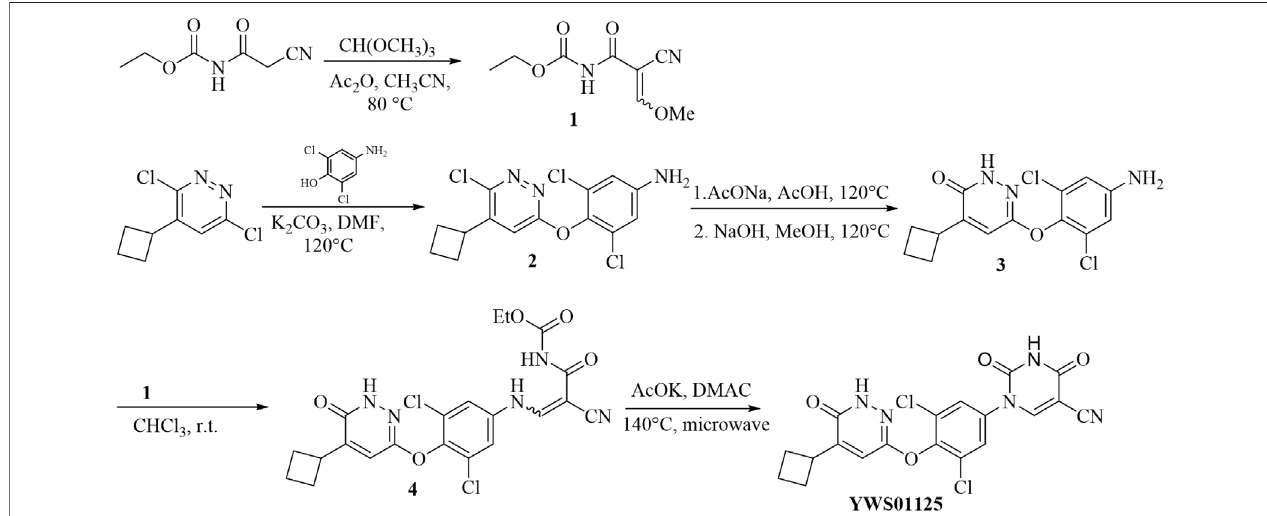
compound 1 as a white solid (2.20 g, 56%). ESI